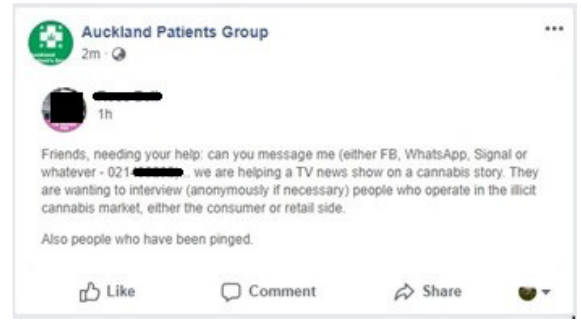
Figure 1. A civil society organisation lobbying for greater access to medicinal cannabis shares a post by a high‐profile cannabis legalisation supporter looking for cannabis market participants for a traditional media